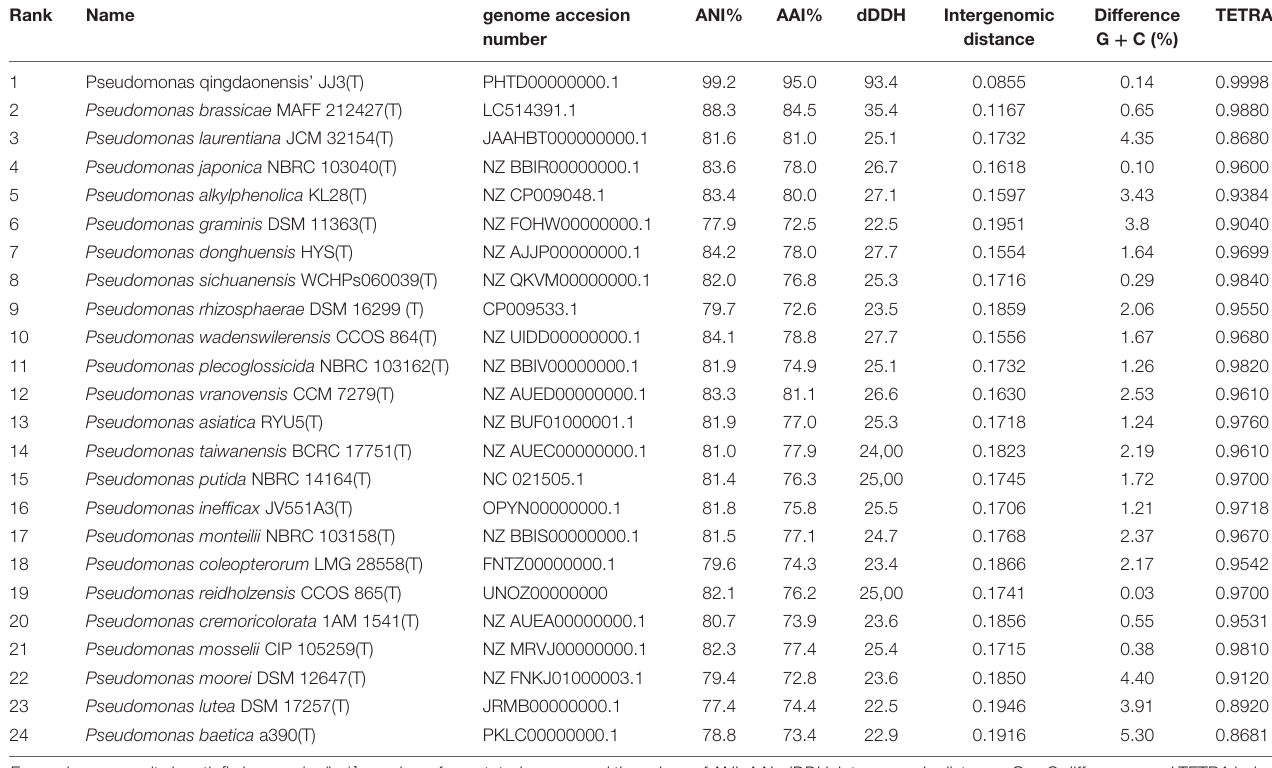
TABLE 3 | Similarity of the 24 genomes with strain BBB001 T